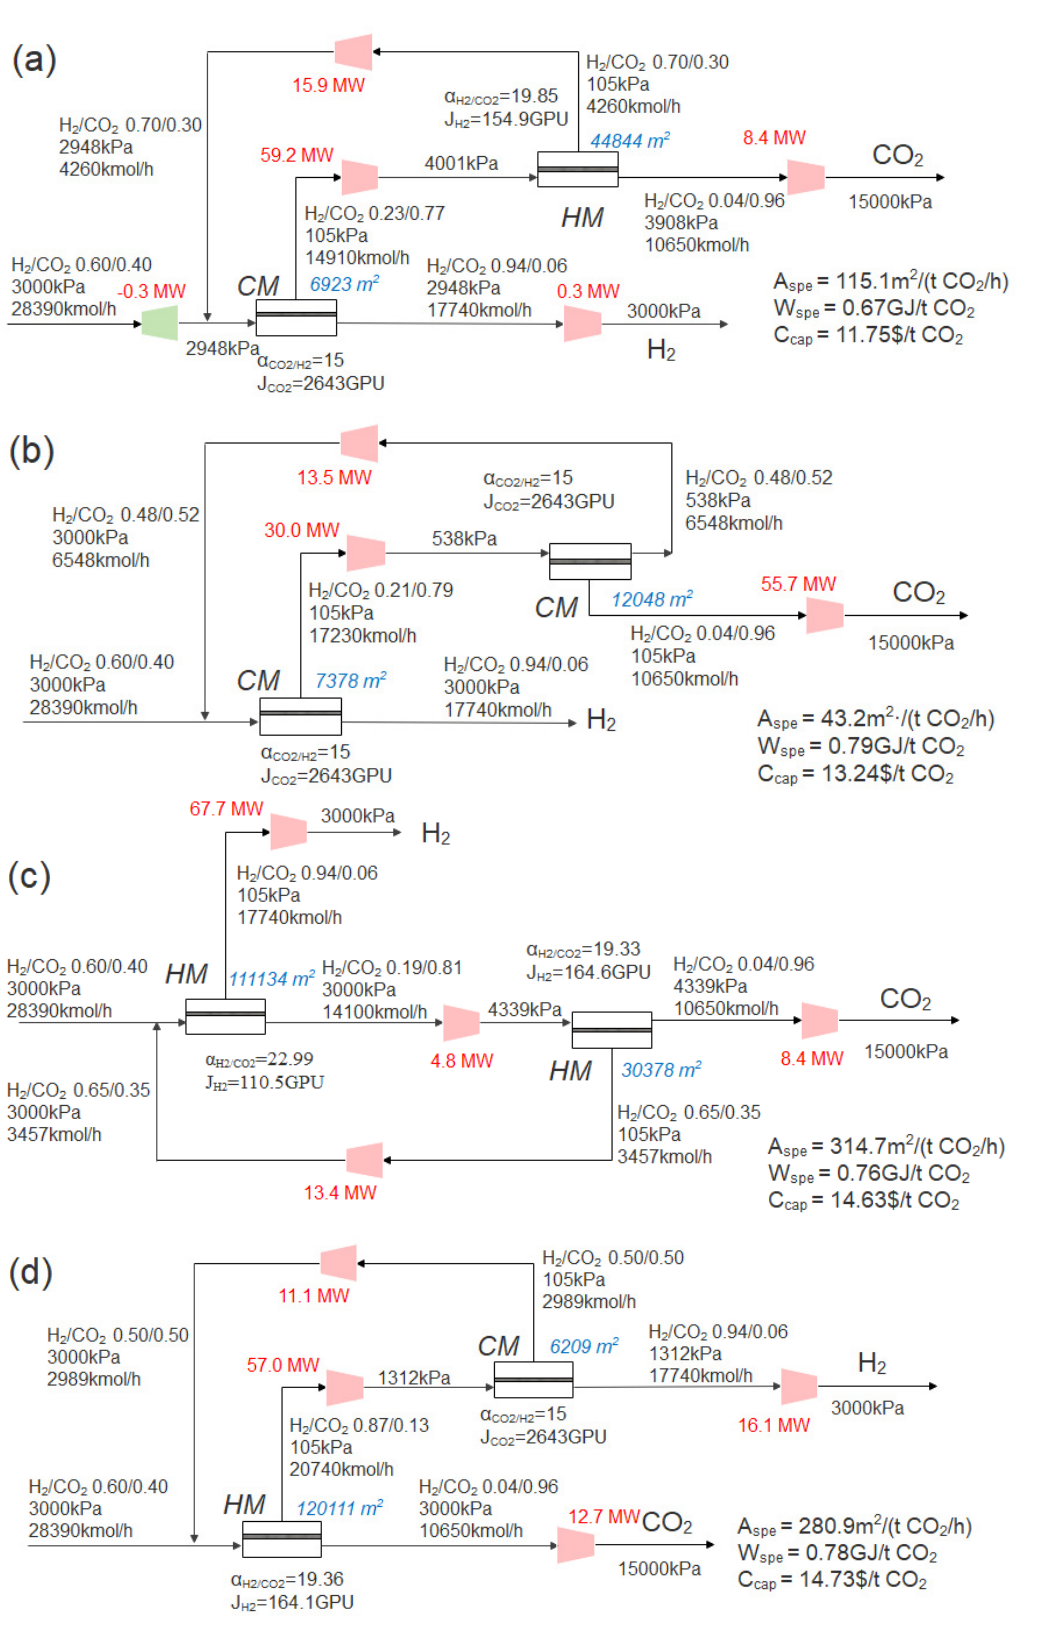
Figure 13. Optimal process of two-stage membrane type combination under the condition of 96% CO 2 purity and 90% CO 2 recovery. ( a ) CM+HM; ( b ) CM+CM; ( c) HM+HM; ( d) HM+CM.